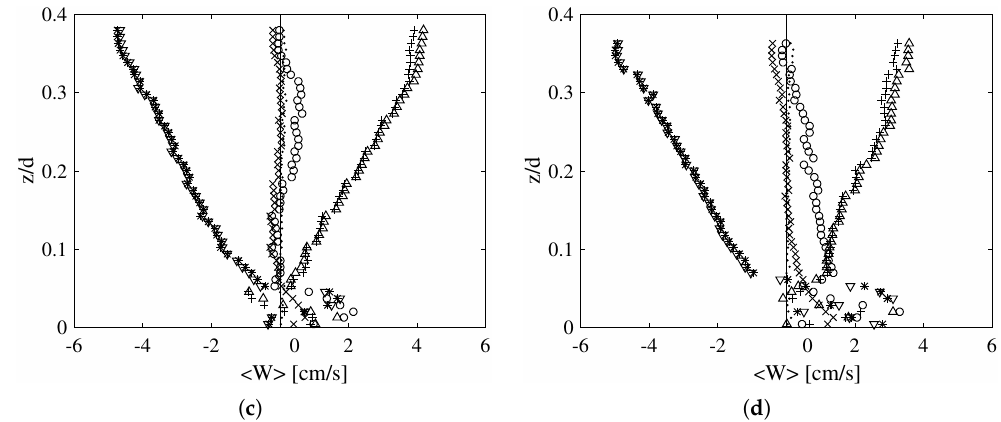
Figure 7. T 9 test ( H = 5.86 m, T = 1.26 s), velocity phase analysis at P 1 : ( a ) U velocity profile at L 2 ; max = 17/32 π , min = 47/32 π ; ( b ) U velocity profile at L 8 ; max = 16/32 π , min = 46/32 π ; ( c ) W velocity profile at L 2 ; max = 13/32 π , min = 49/32 π ; and ( d ) W velocity profile at L 8 ; max = 14/32 π , min = 49/32 π .